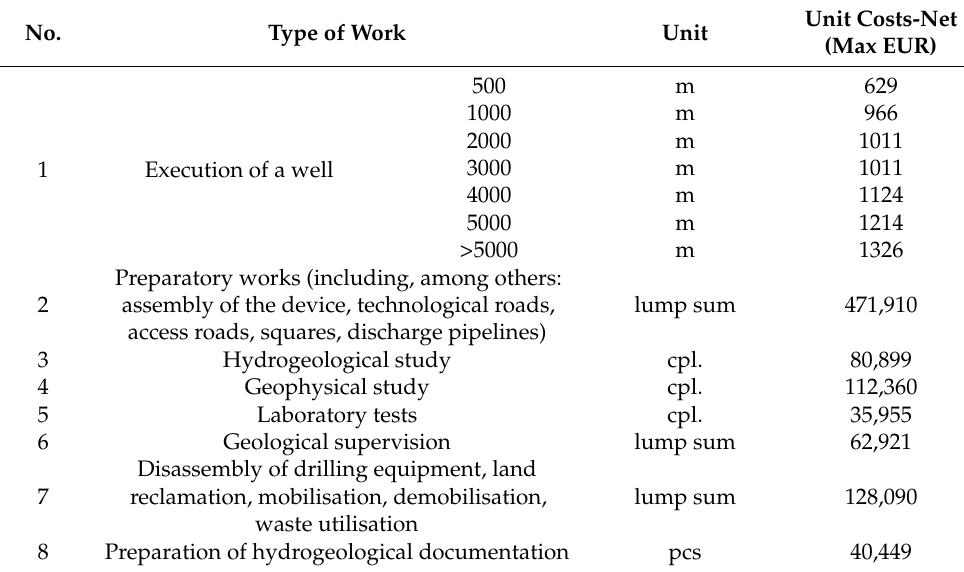
Table 8. National Fund for Environmental Protection and Water Management guidelines for geother- mal drilling work